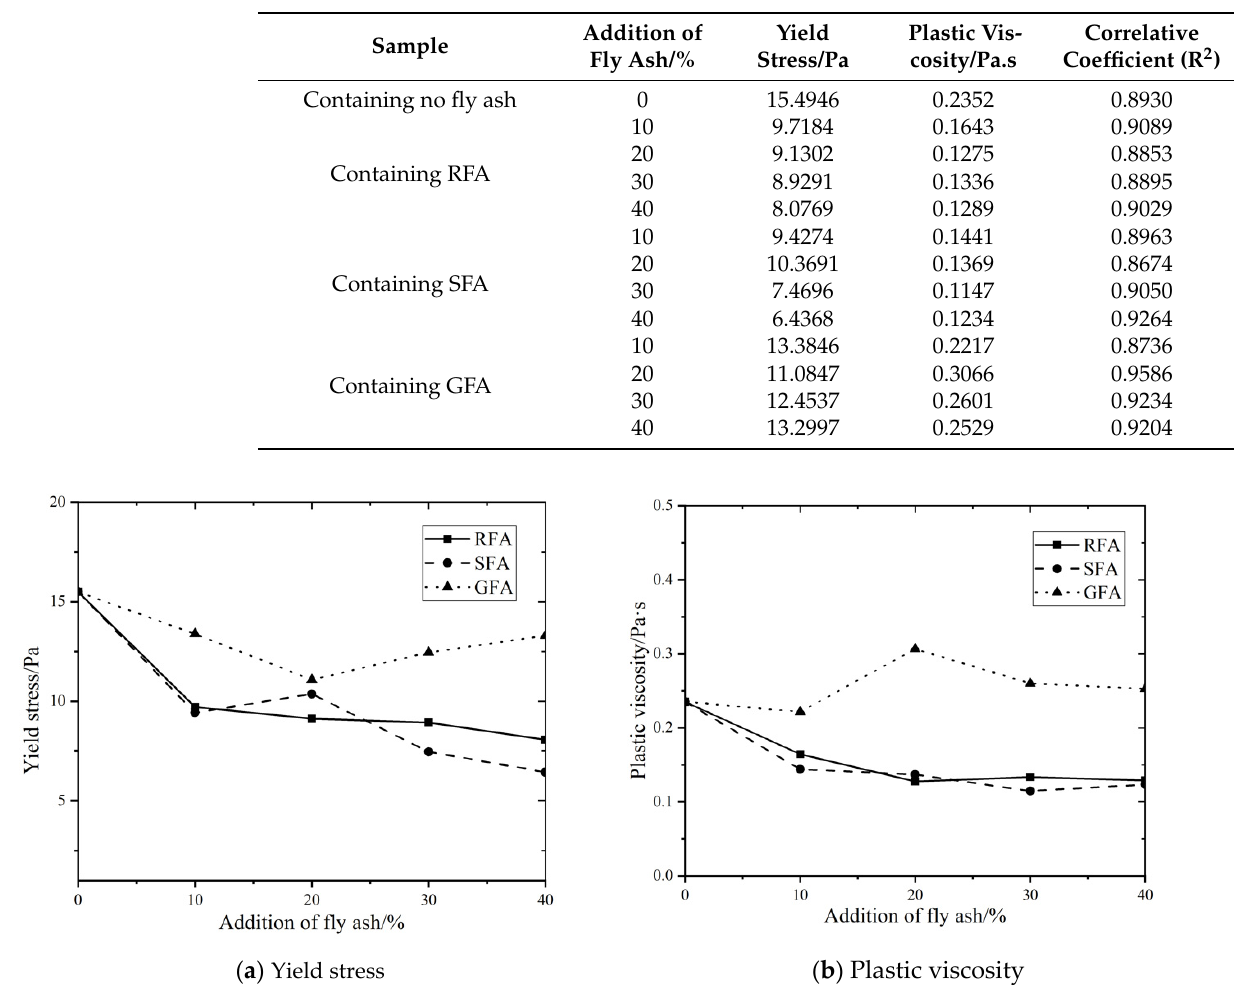
Table 5. Rheological parameters of cement paste containing different fly ash.